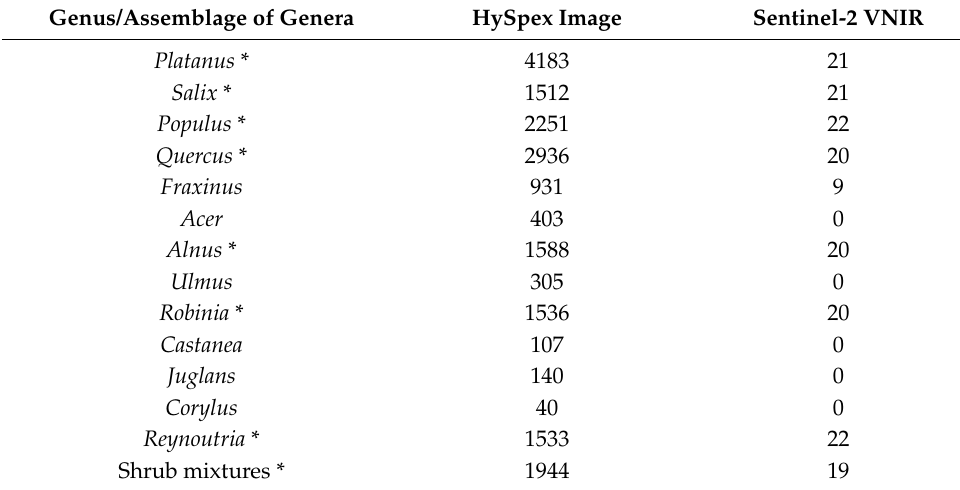
Table 2. Predominant plant genera or assemblages, and corresponding pixel numbers on hyper- spectral and Sentinel-2 images. The classes finally selected in the classification are indicated by an asterisk.